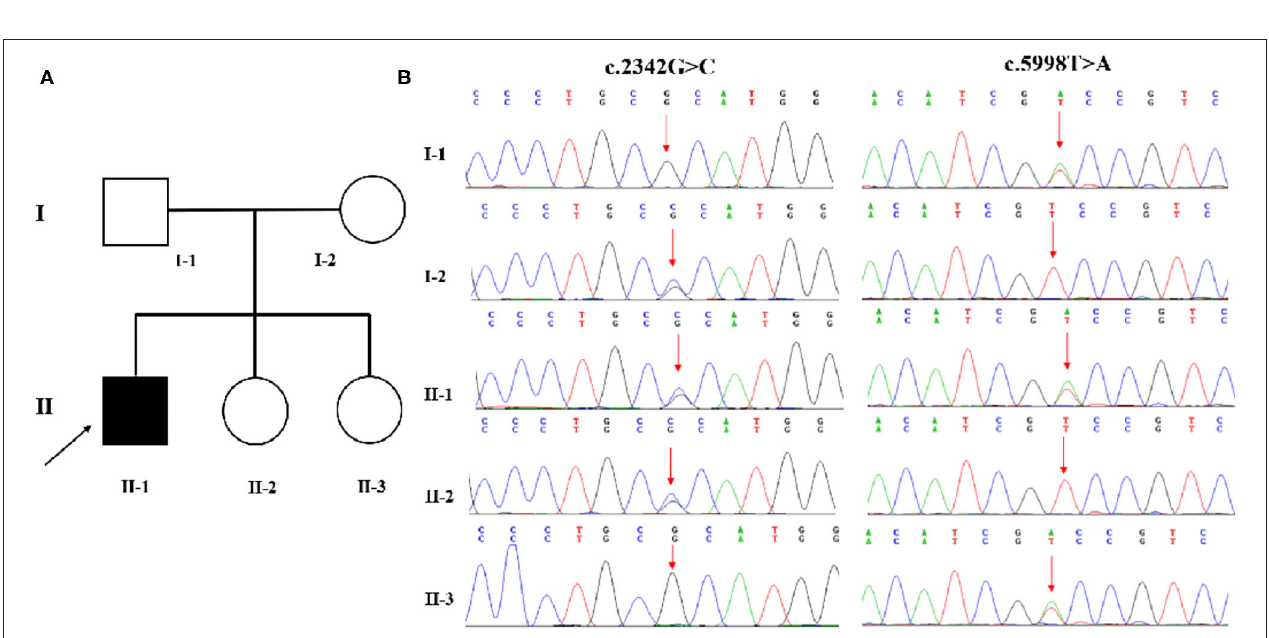
FIGURE 1 | (A,B) EEG showed poor background with multiple spikes and spike-and-wave discharges. (C,D) Brain MRI presented mega cisterna magna, together with enlarged left lateral ventricle.